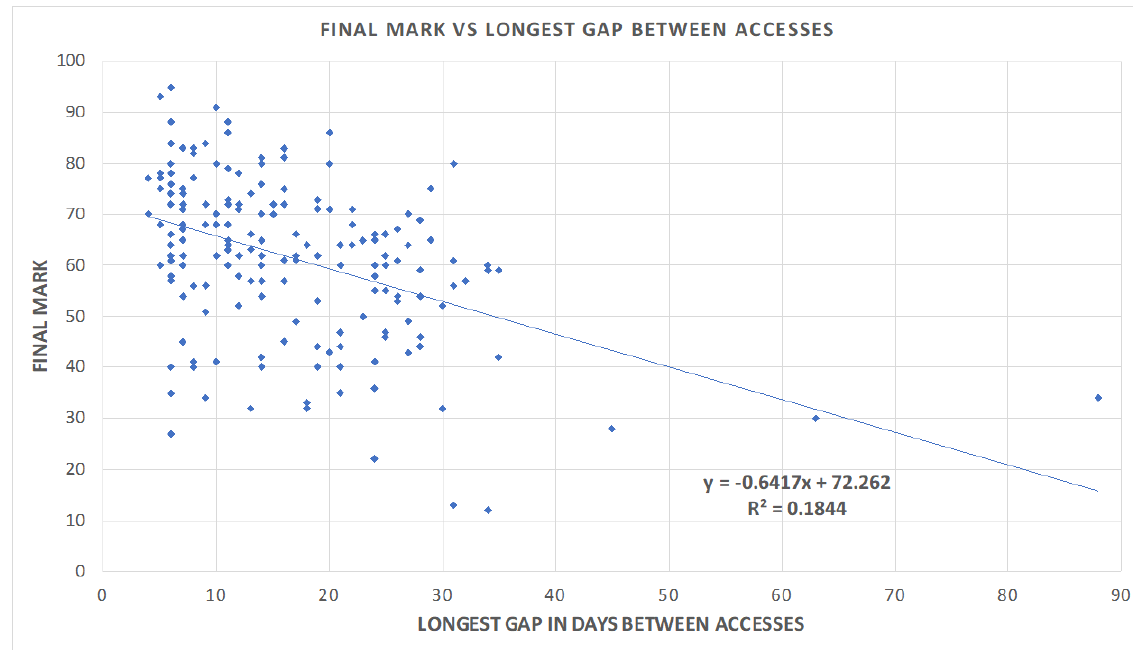
Figure 10 . Final Mark vs Longest gap between accesses